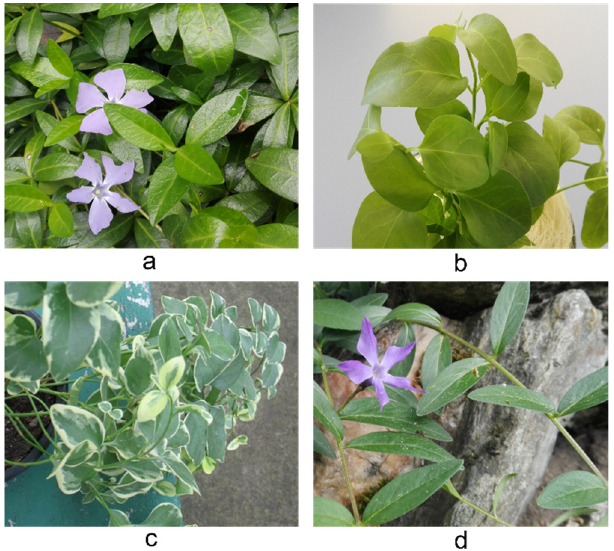
Figure 10. The aerial parts of the Vinca plants: ( a ) V. minor , ( b ) V. major , ( c ) V. major var. variegata , and ( d ) V.